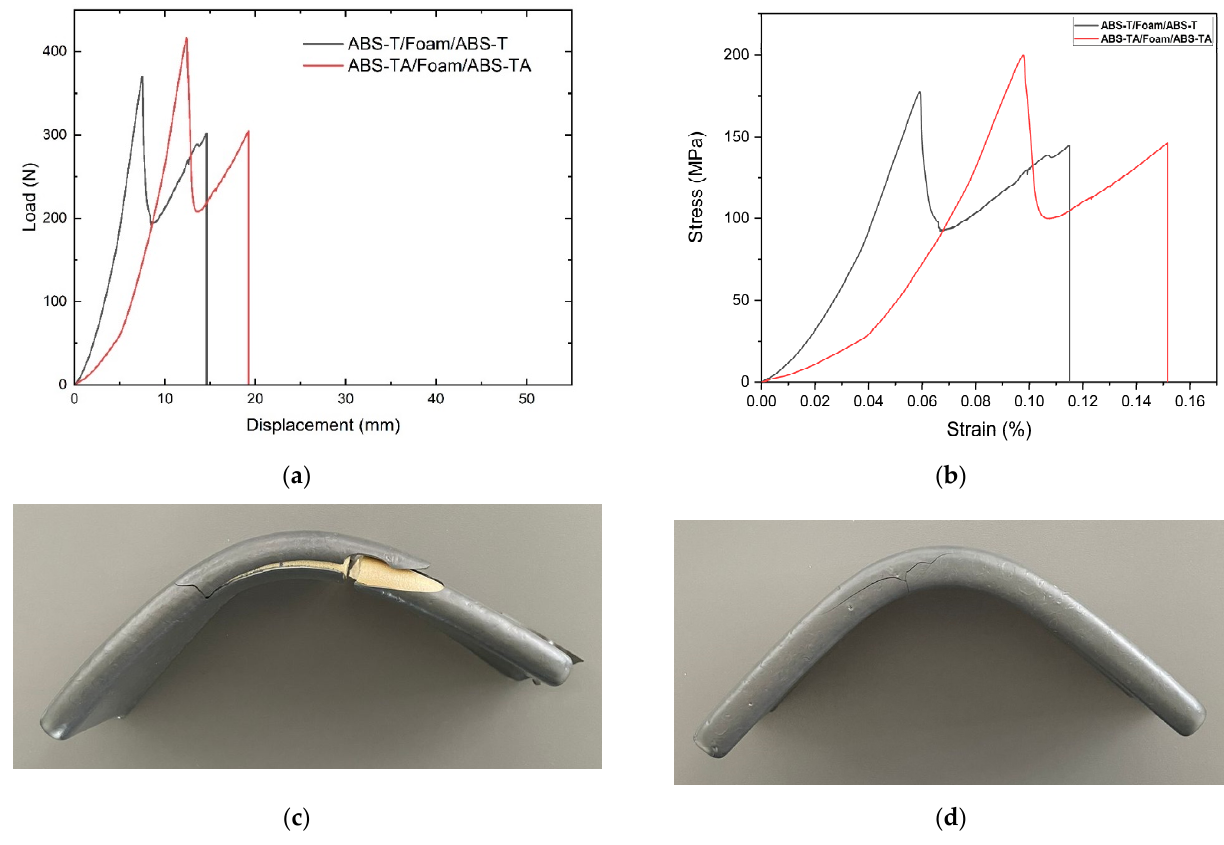
Figure 14. Mechanical behavior and failure: ( a ) r epresentative load vs. displacement curves, ( b ) representative stress vs. strain curves registered during the bending tests, ( c ) failure of the ABS ‐ T/Foam/ABS ‐ T panels, and ( d ) failure of ABS ‐ TA/Foam/ABS ‐ TA panels. The pictures present the damages that occurred during the test.